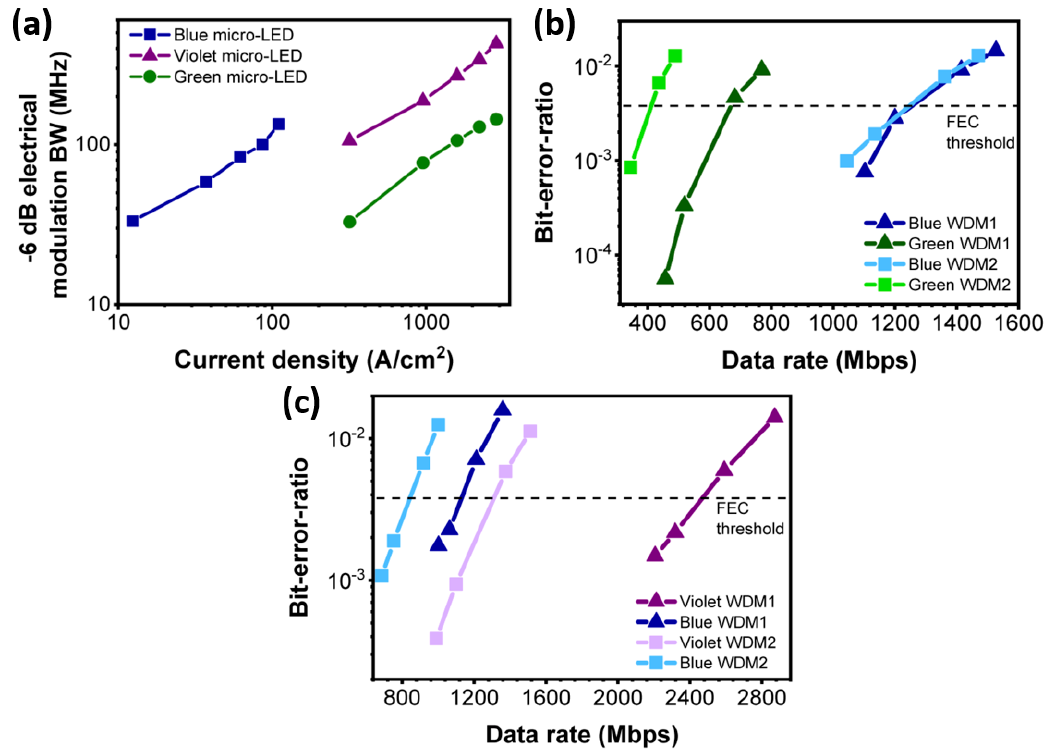
Figure 7. ( a ) -6 dB modulation bandwidth for violet, green and blue µ -LEDs as a function of current density; ( b ) bit error rate (BER) versus data rate for blue and green µ -LEDs in both wavelength division multiplexing (WDM) schemes; ( c ) BER versus data rate for blue and violet µ -LEDs in both WDM schemes. [77] Figures reproduced with permission from Optical Society of America.